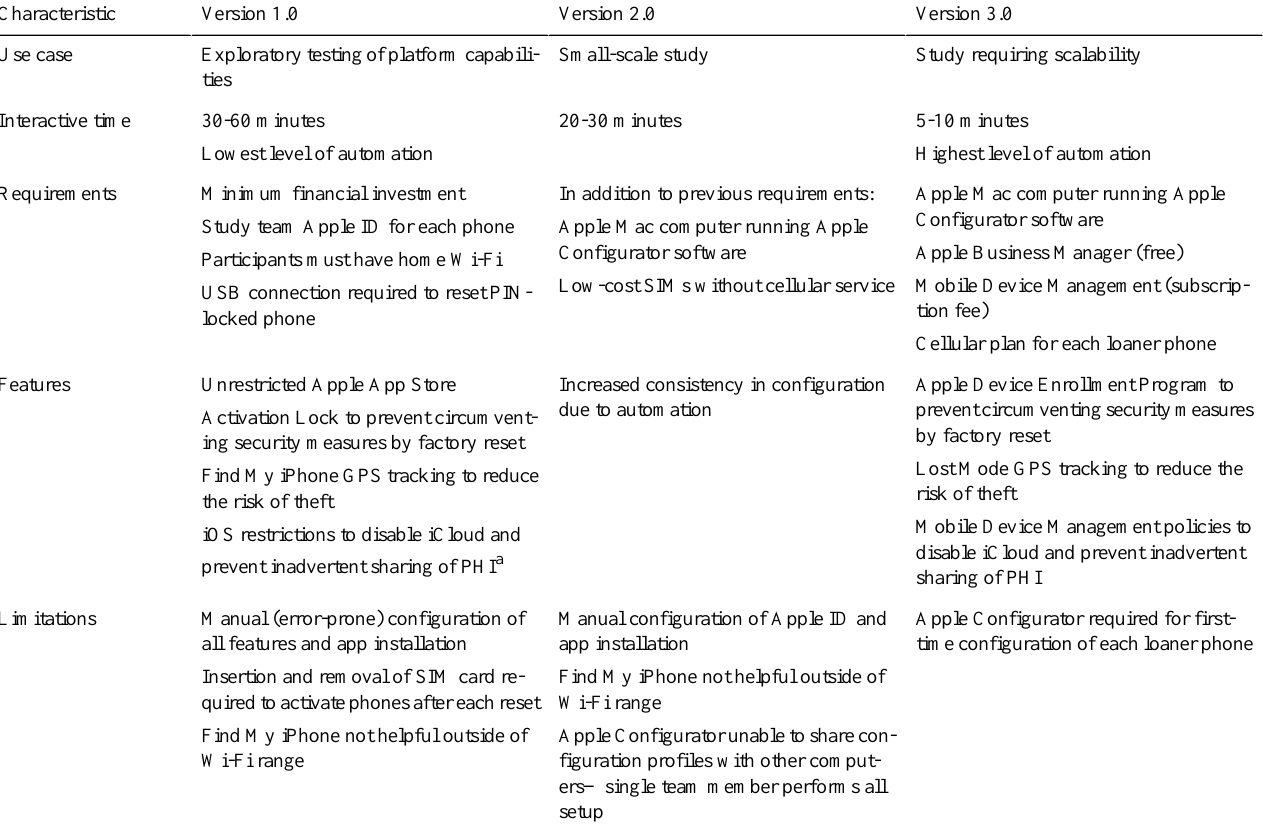
Table 1. Use cases and characteristics of each protocol version.